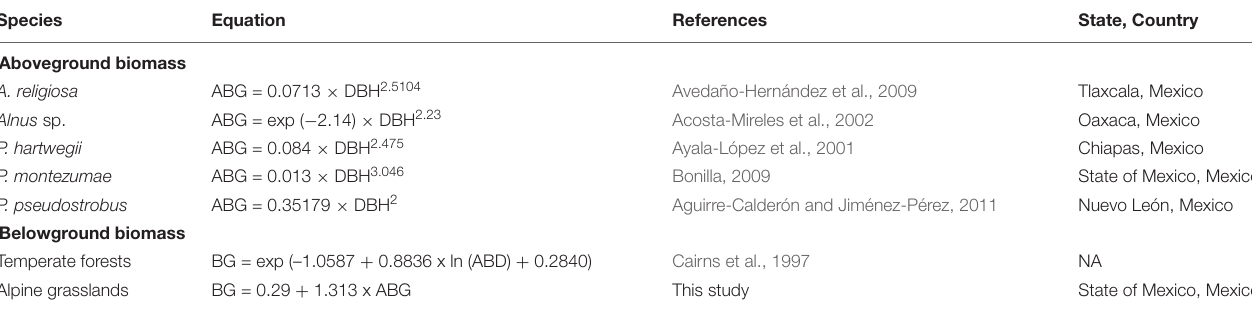
TABLE 2 | Allometric equations for the calculation of aboveground and belowground biomass of the studied species. Species